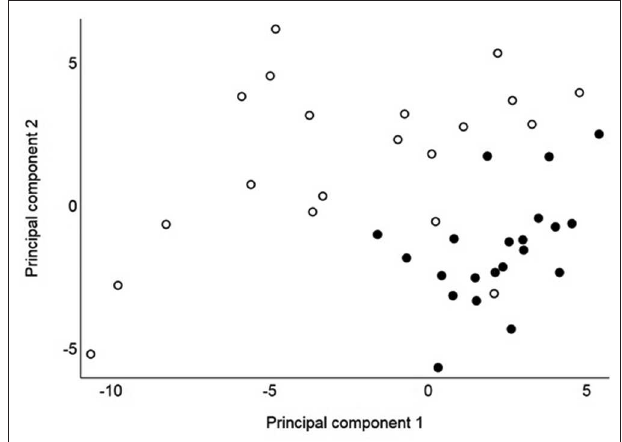
FIGURE 1 | Principal component values from 41 cats for the first and second components based on concentrations of 61 identified GCMS compounds assessed in 20 cats in remission (hollow circles) and 21 healthy control cats (solid